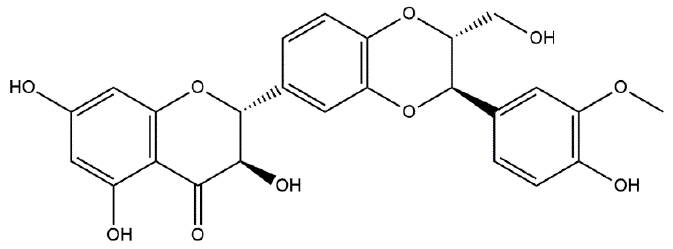
Figure 23. Schematic representation of silymarin’s chemical structure.